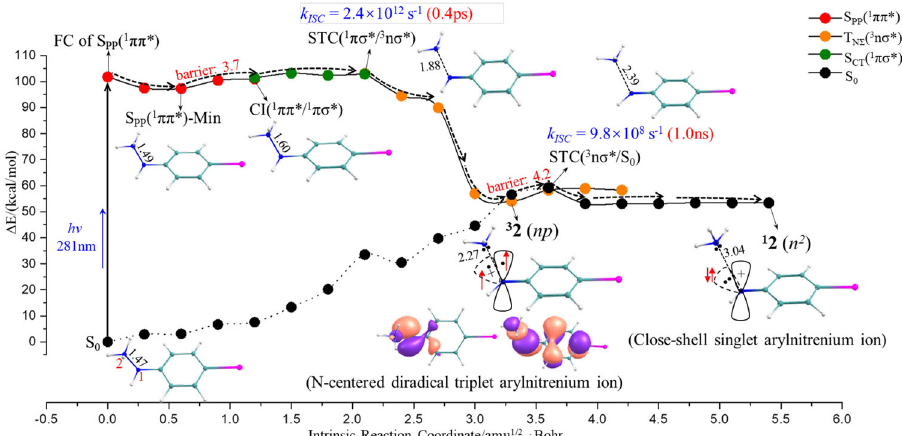
Fig. 3 Minimum energy pro fi les (MEPs) for the photolysis of 1 producing the N-centered diradical 3 2 ( np ) and closed-shell singlet 1 2 ( n 2 ) along the reaction channels of the singlet and triplet states. The MEPs calculated at the CASPT2//CASSCF/PCM/cc-pVDZ level of theory, in which the line with red dots represents the S PP ( 1 ππ *) state, the line with green dots represents the S CT ( 1 πσ *) state, the line with orange dots represents the T N Σ ( 3 n σ *) state and the line with black dots represents the S 0 state. Selected stationary structures are given with their key bond (N – N) lengths in Å while the singly occupied molecular orbitals for the selective arylnitrenium ions are schematically provided. The value of 3.7 kcal/mol is the barrier required to be overcome to reach the CT( 1 ππ */ 1 πσ *) from the S PP ( 1 ππ *)-Min, while the value of 4.2 kcal/mol is the barrier required to be overcome to arrive at the STC( 3 n σ */S 0 ) from 3 2 ( np ). The energy for each point in the MEPs and the structures for critical points are shown in the Supplementary Data File (FC Frank-Condon, STC singlet-triplet crossing; ISC intersystem crossing, CI = conical